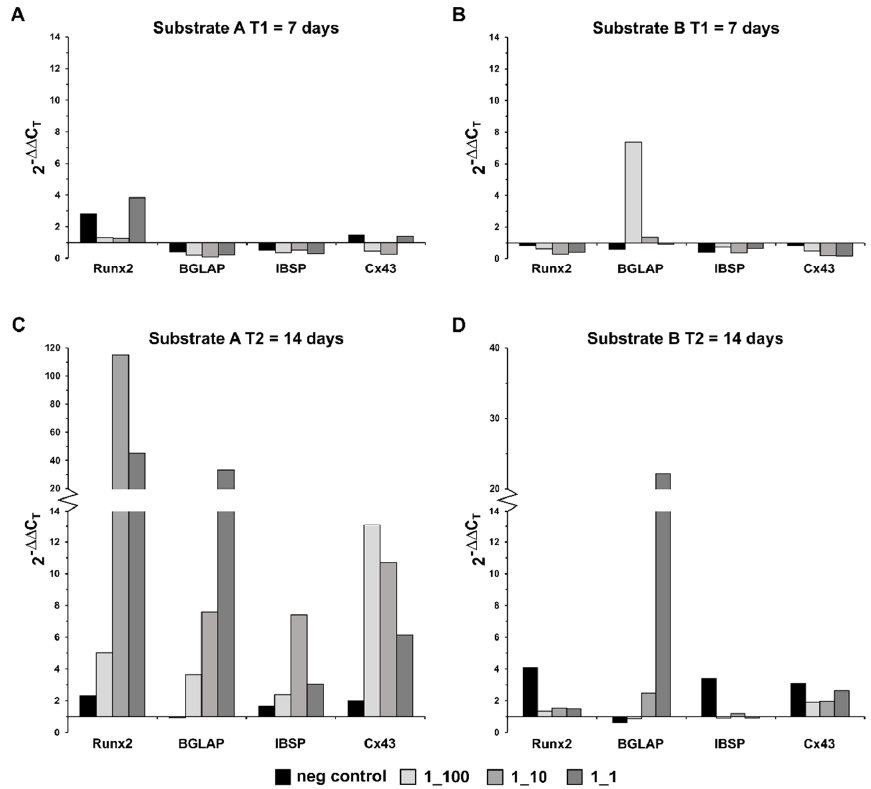
Figure 3. Relative expression differences of the target genes to the housekeeping gene GAPDH compared to the positive control in cells from the substrate A (NPCM, left ) and substrate B (RCCM, right ) after 7 and 14 days. ( A ) xHyA in 1_1 dilution used on substrate A enhanced only Runx2 expression by factor 4 at T1, ( B ) on the substrate B only BGLAP displayed enhanced expression rate under xHyA at 1_100 dilution at T1, ( C ) xHyA dilutions of 1_10 and 1_1 on substrate A upraised the expression of Runx2 and BGLAP to 120 and 44 fold, respectively, while highest level of Cx43 expression was measured at 1_100 dilution of xHyA, ( D ) only BGLAP showed increased expression on the substrate B treated with 1_1